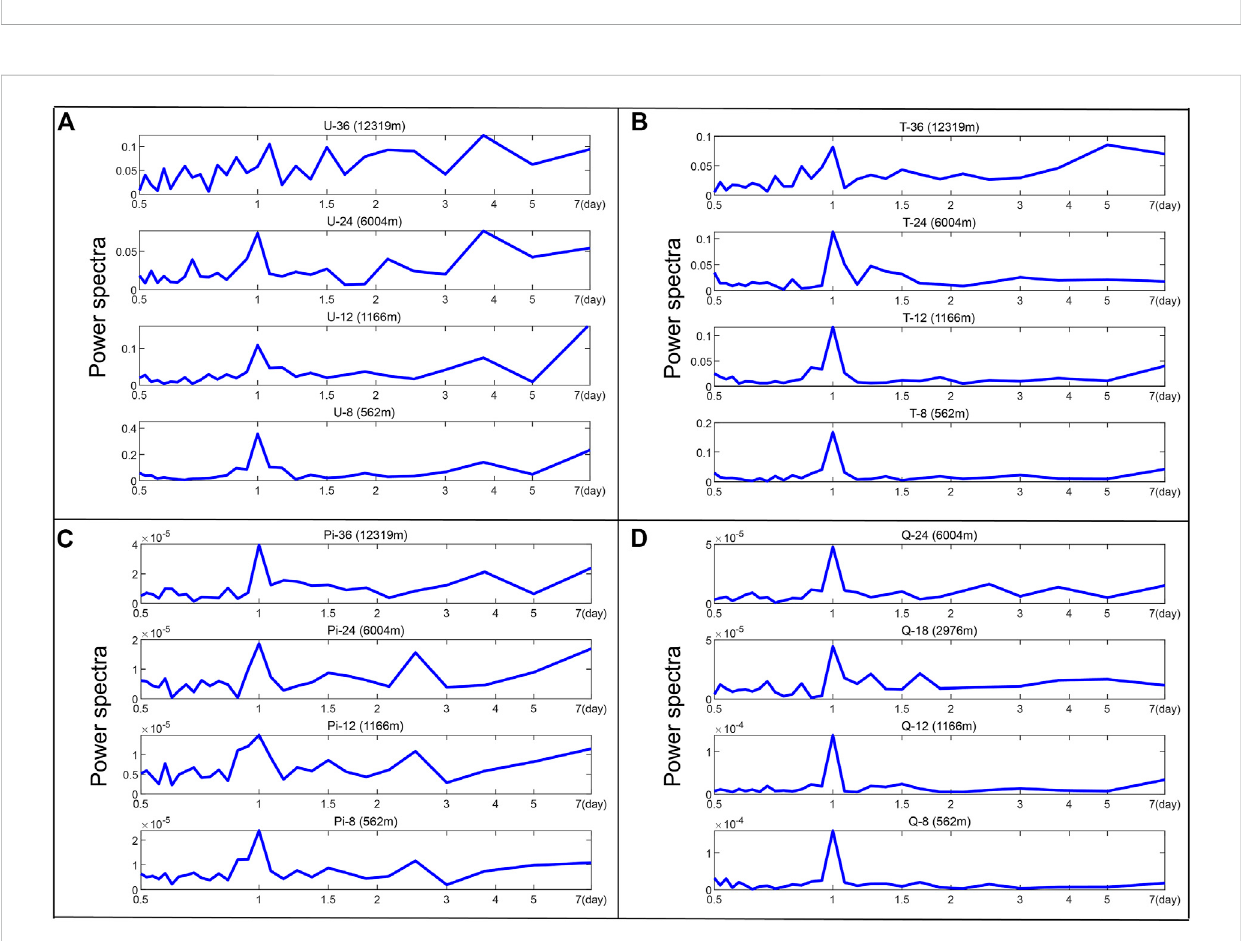
The power spectra of (A) U, (B) T, (C) Pi, and (D) Q in the forecast mean bias time series from June 1 to 15,